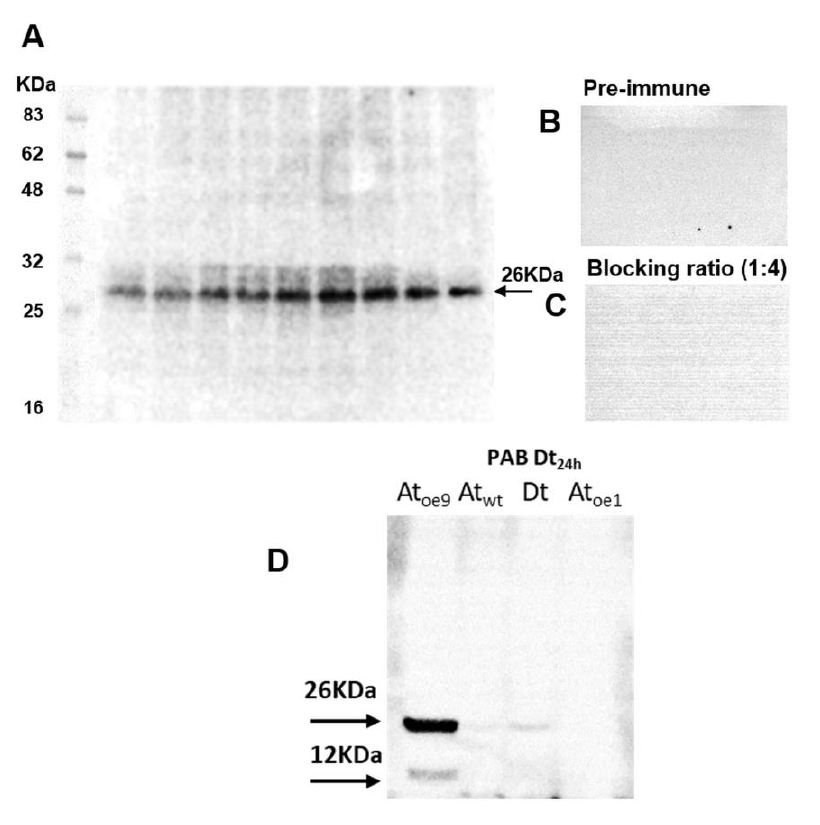
( Fig. 2D ). The last control corresponded to  -AtMC9 blocked with pure rubisco. In this case, the 60 KDa band from D. tertiolecta and the 35 KDa band from A. thaliana were again detected ( Fig. 2E